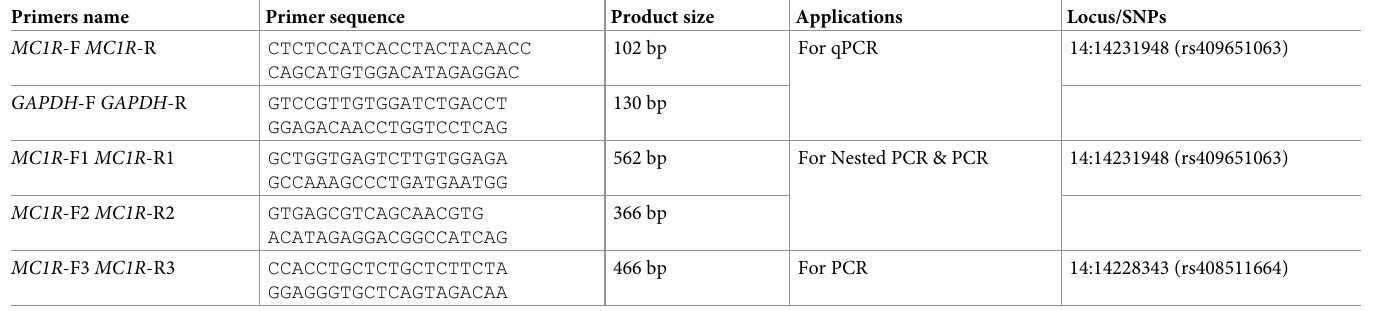
Table 1. Primer information for qPCR, nested PCR and PCR